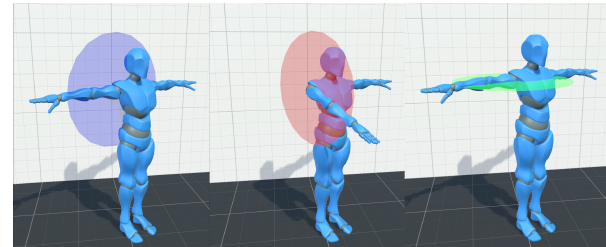
Figure 2. Coronal (left), Sagittal (center) and Transverse (right) anatomical planes. The arm moves along the highlighted area and create distinct move-